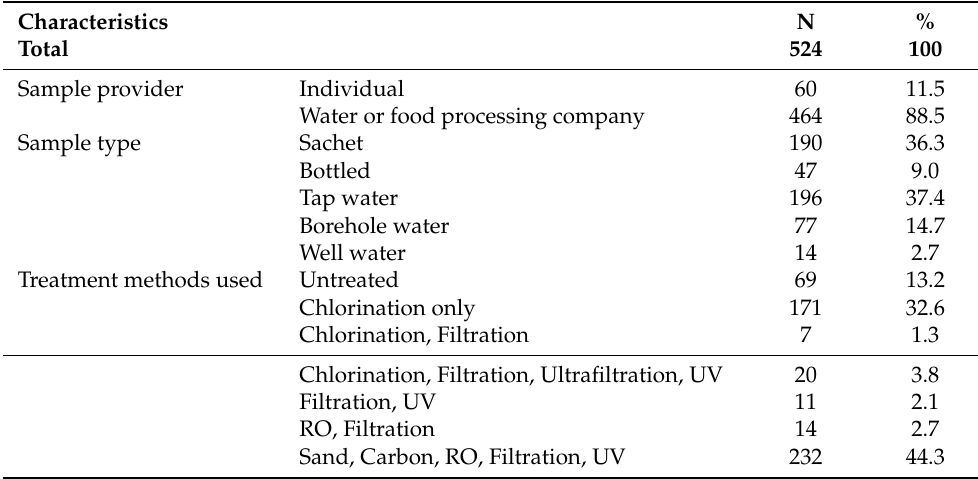
Table 1. Characteristics of water samples brought to the Water Research Institute for microbial water quality analysis from suburbs within Greater Accra region, Ghana (December 2021–March